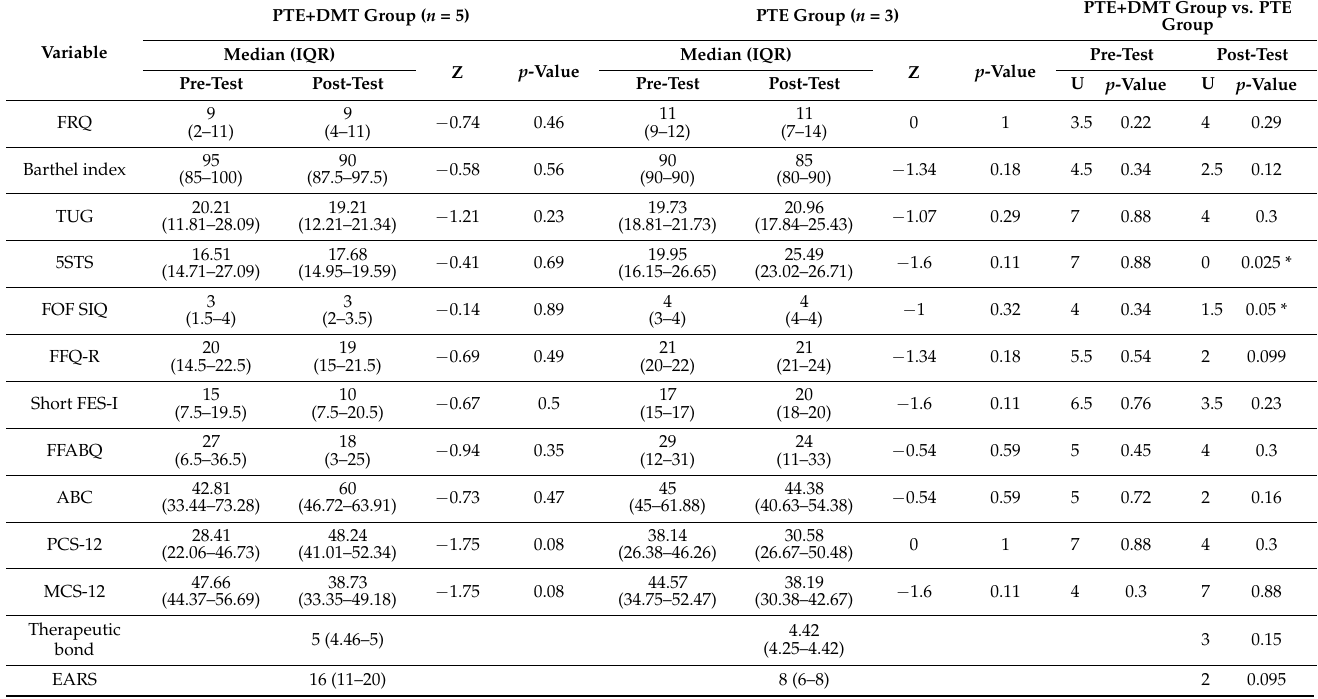
Table 2. Pre-test and post-test between and within groups differences results expressed by Wilcoxon test and Mann/Whitney U